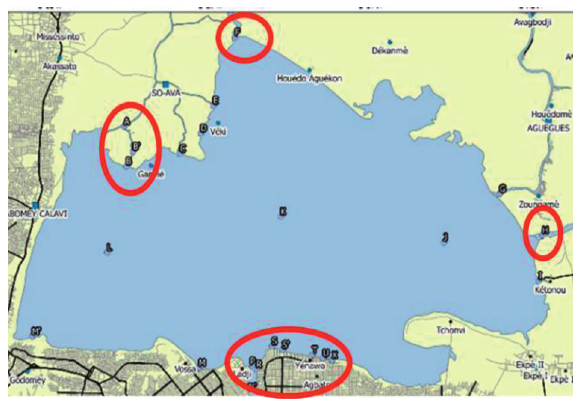
Figure 10: Visualization of sites with a high Igeo.